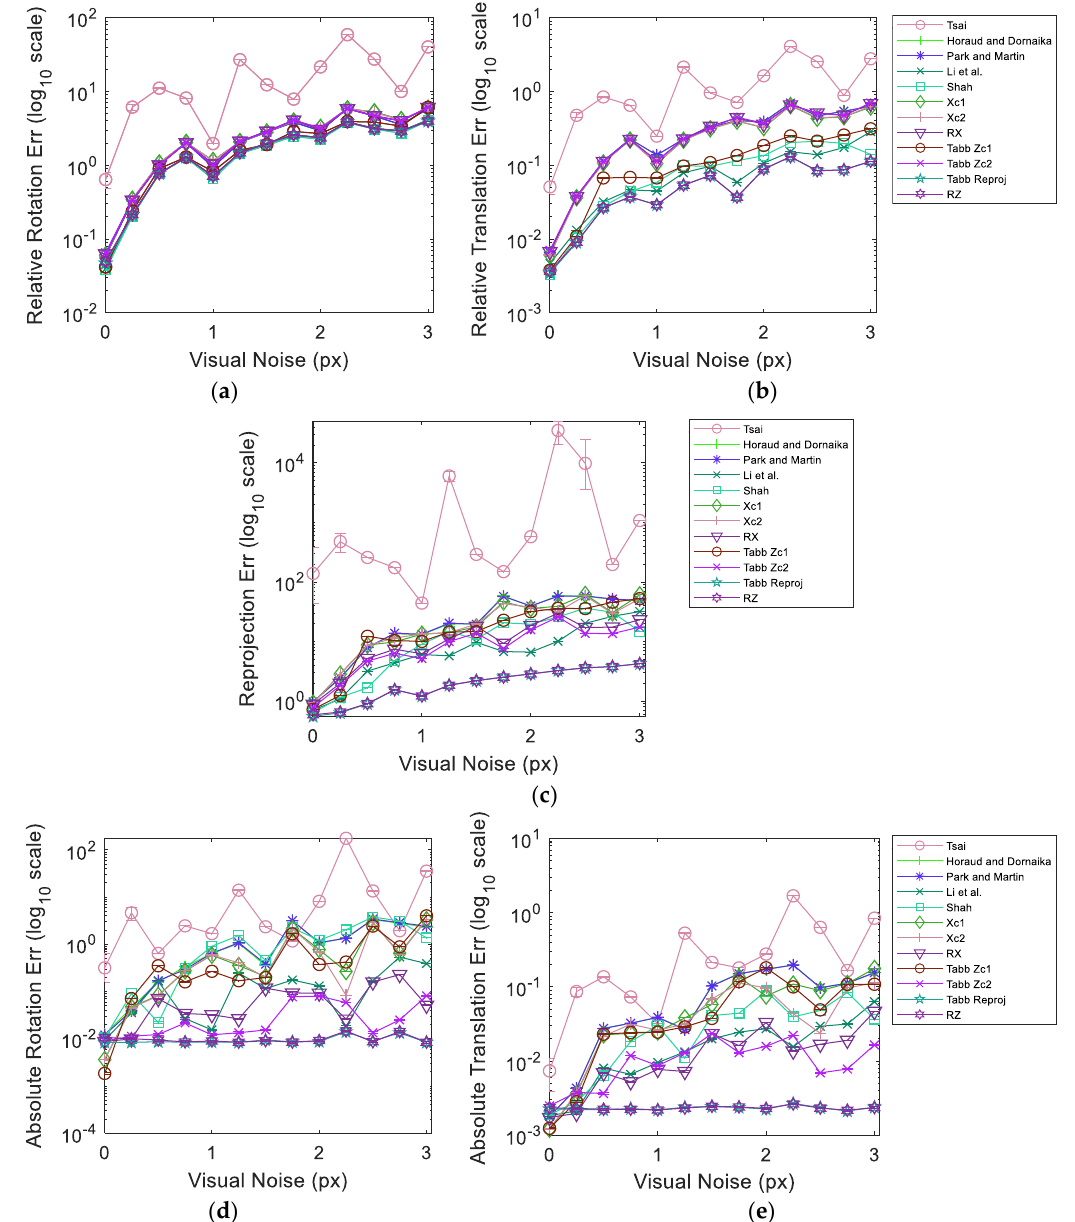
Figure 7. Metric error results for Dataset 5 with constant robot pose noise; ( a ) mean rotation error; ( b ) mean translation error; ( c ) reprojection error; ( d ) absolute rotation error against ground truth; ( e ) absolute translation error against ground truth.